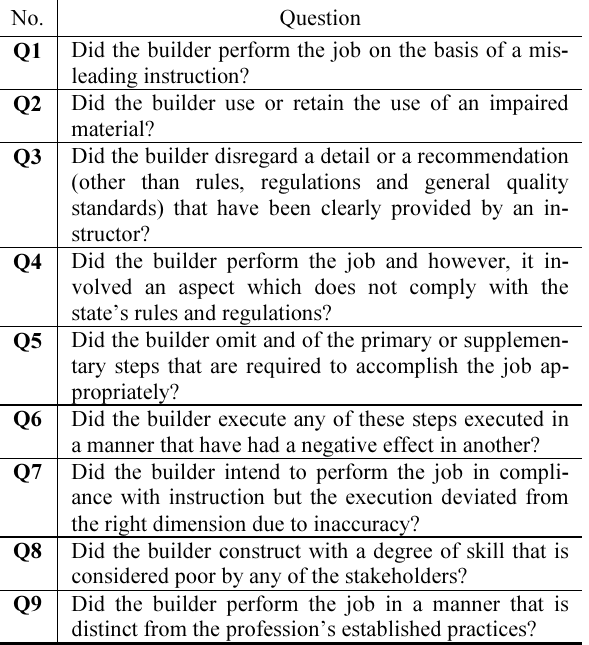
Fig. 2. A flow chart for classifying defective acts Table 2. Questions for classifying defective